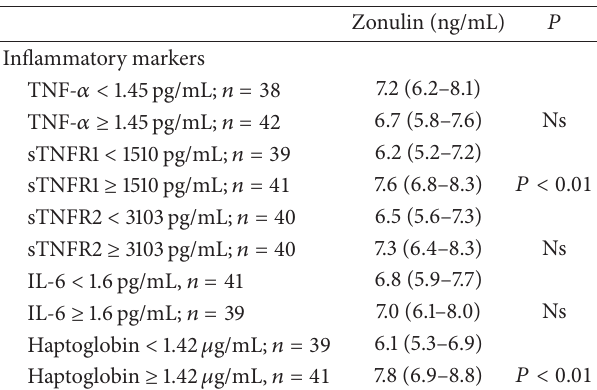
Table 3: The comparison of zonulin concentrations in groups according to different parameters (mean and 95%